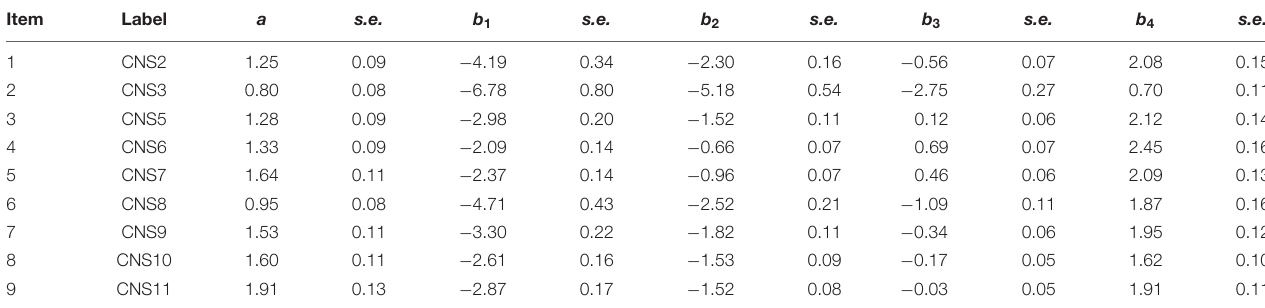
TABLE 3 | Estimates of the parameters of the items of the graded response model.